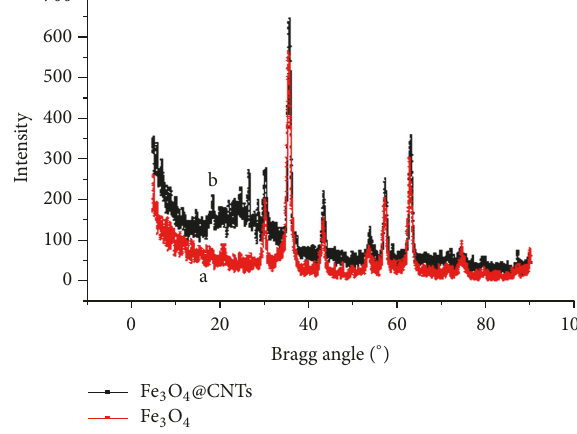
Figure 3: X-ray diffraction patterns of (a) Fe 3 O 4 MNPs and (b) Fe 3 O 4 @CNTs